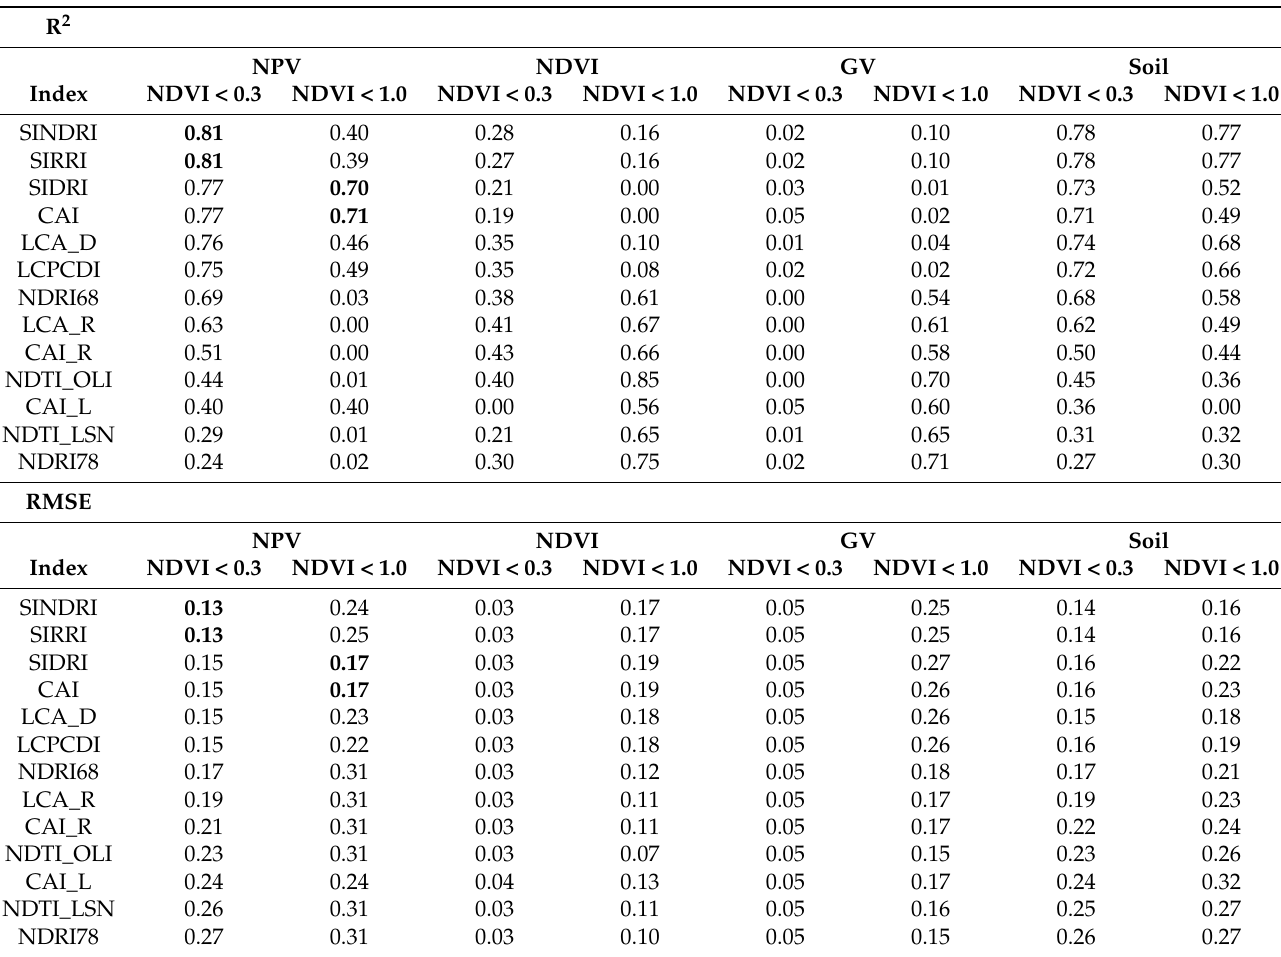
Table 2. Correlation (R 2 ) and root mean squared error (RMSE) between shortwave infrared (SWIR) indices and fractional cover of non-photosynthetic vegetation (NPV), green vegetation (GV), and soil, as well as NDVI, for datasets limited to NDVI < 0.3 ( n = 640) and to the full range of NDVI < 1.0 ( n = 619). See Table 1 for index definitions. Derived from boxcar spectra using 20, 20, 40, 40, and 40 nm bandwidths, respectively, for the 2040, 2100, 2210, 2260, and 2330 nm band